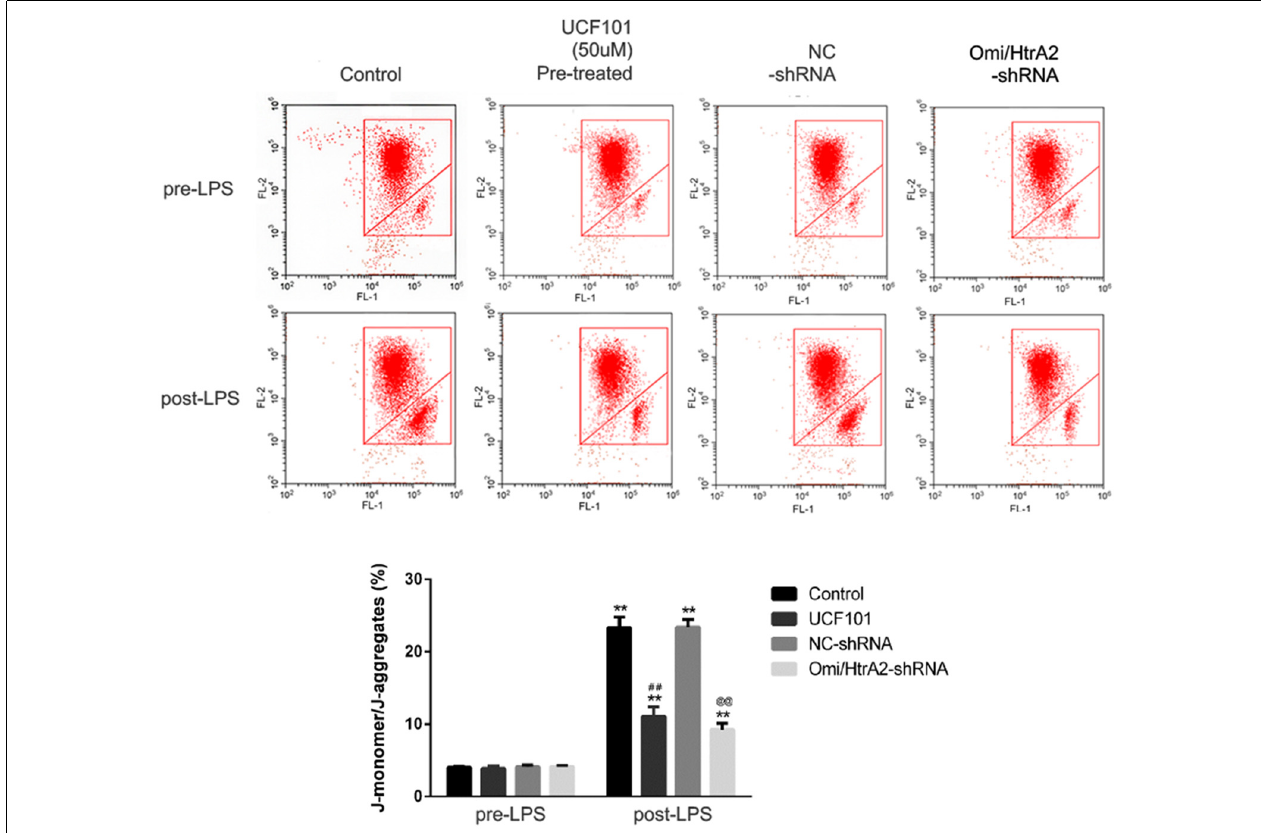
FIGURE 9 | Effects of inhibition of Omi/HtrA2 by UCF-101 or Omi/HtrA2 shRNA on MMP in LPS-treated hCMEC/D3 monolayers as determined by JC-1 staining using flow cytometric detection. The results are expressed as the ratio of J-monomers to aggregates. ∗∗ P < 0.01, vs. pre-LPS, ## P < 0.01, vs. control, @@ P < 0.01, vs.